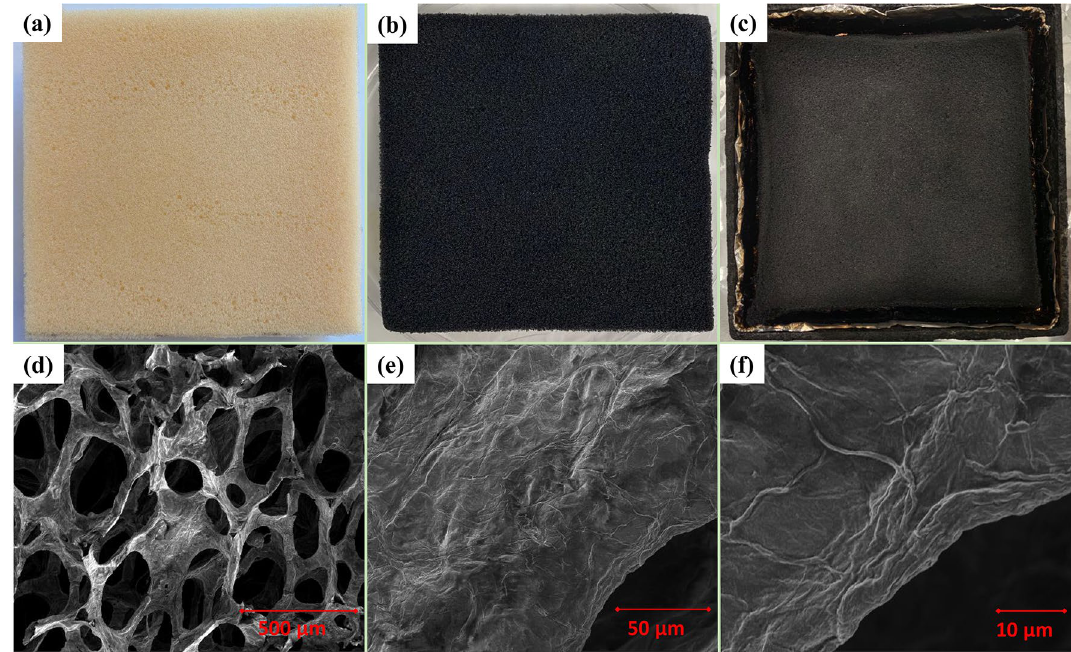
Figure 7. Digital images of ( a ) pure PUF, ( b ) [CH/PA/Ti 3 C 2 ] 3 PUF, and ( c ) [CH/PA/Ti 3 C 2 ] 3 PUF after Cone test; and SEM images of ( d , e , f ) [CH/PA/Ti 3 C 2 ] 3 PUF after Cone